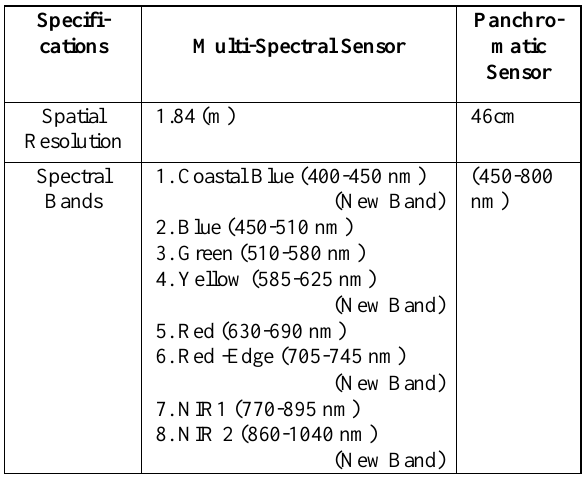
Table 1: Spectral bands of WorldView-2 data